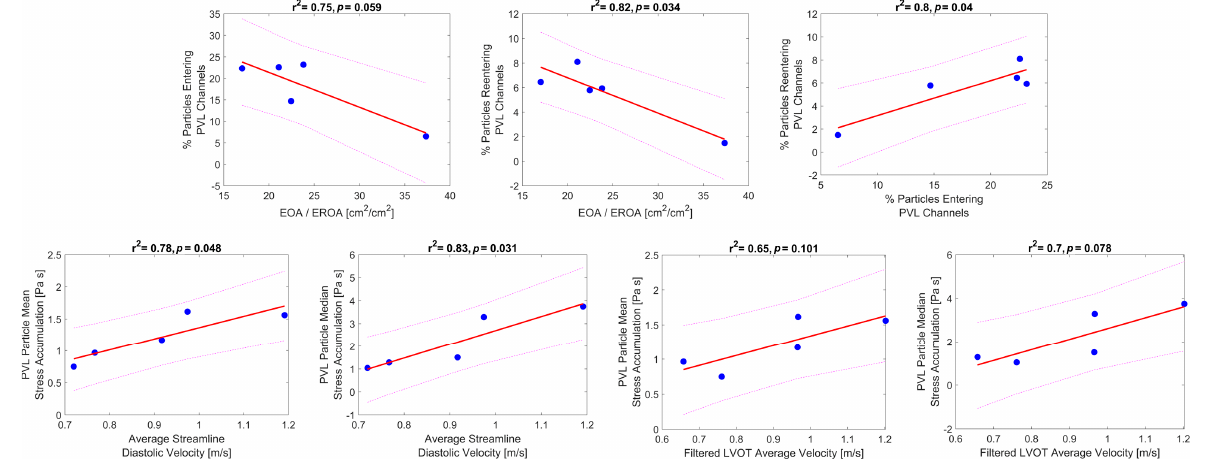
Figure 7. Emerging linear trends from the 5 cases—Top row—linear correlations showing the tendency of platelets to enter or reenter the PVL channels. Bottom row—linear correlations of the median and mean stress accumulation of the PVL platelets to the diastolic streamline velocity and the average velocity (>0.3 m/s) in a transverse plane of the LVOT.